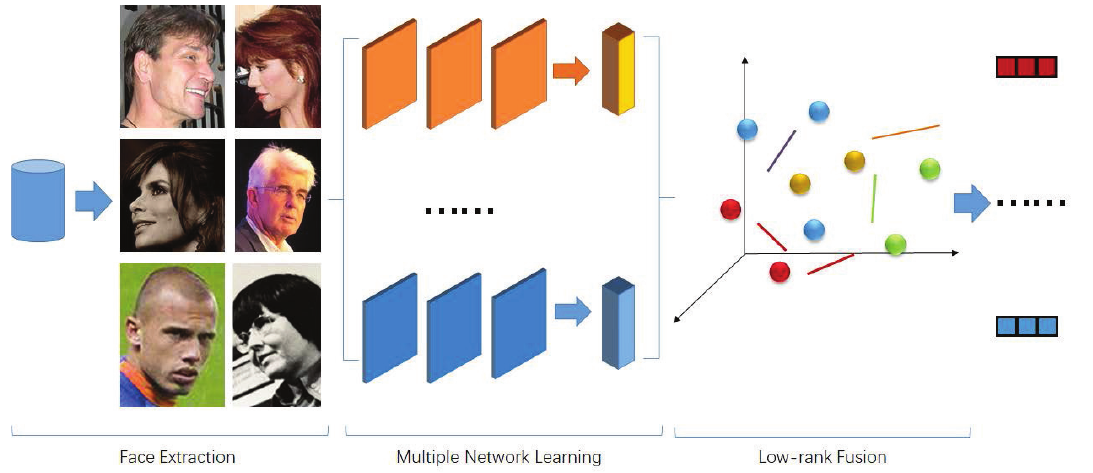
Figure 1. The flowchart of the proposed method (Multiple Network Fusion with Low-Rank Representation